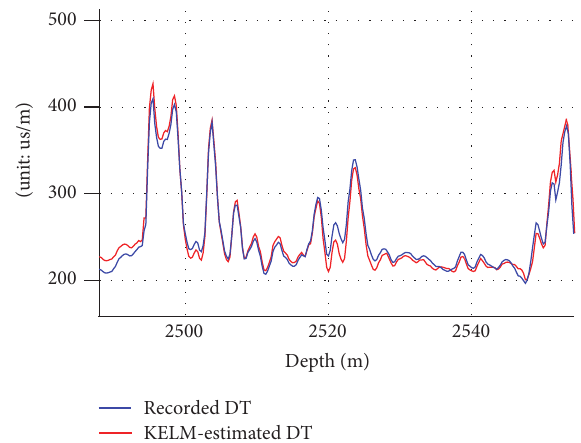
Figure 3: Logs comparison in Shanxi group of Permian formation in well S215.